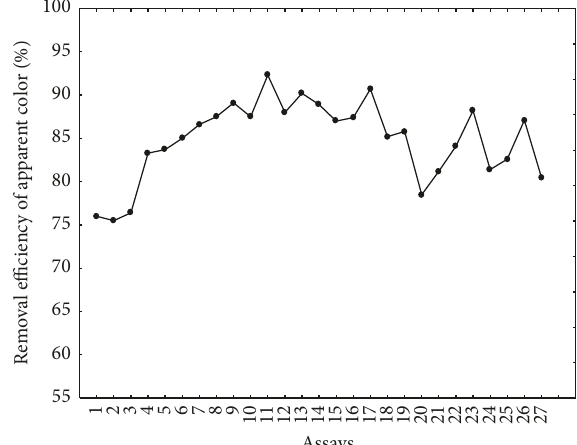
Table 2: Coagulants dosage in association.